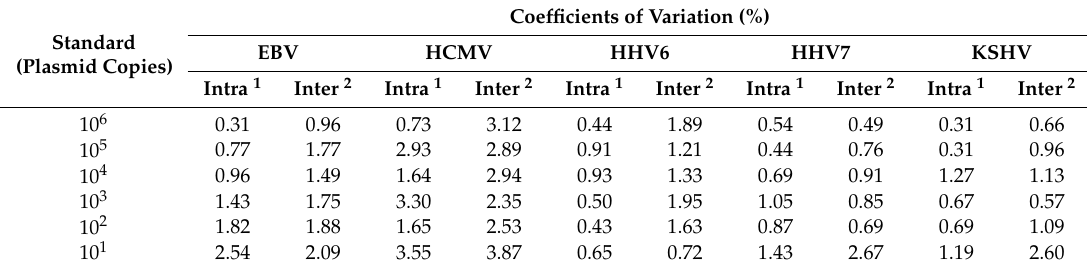
Table 3. Precision of multiplex